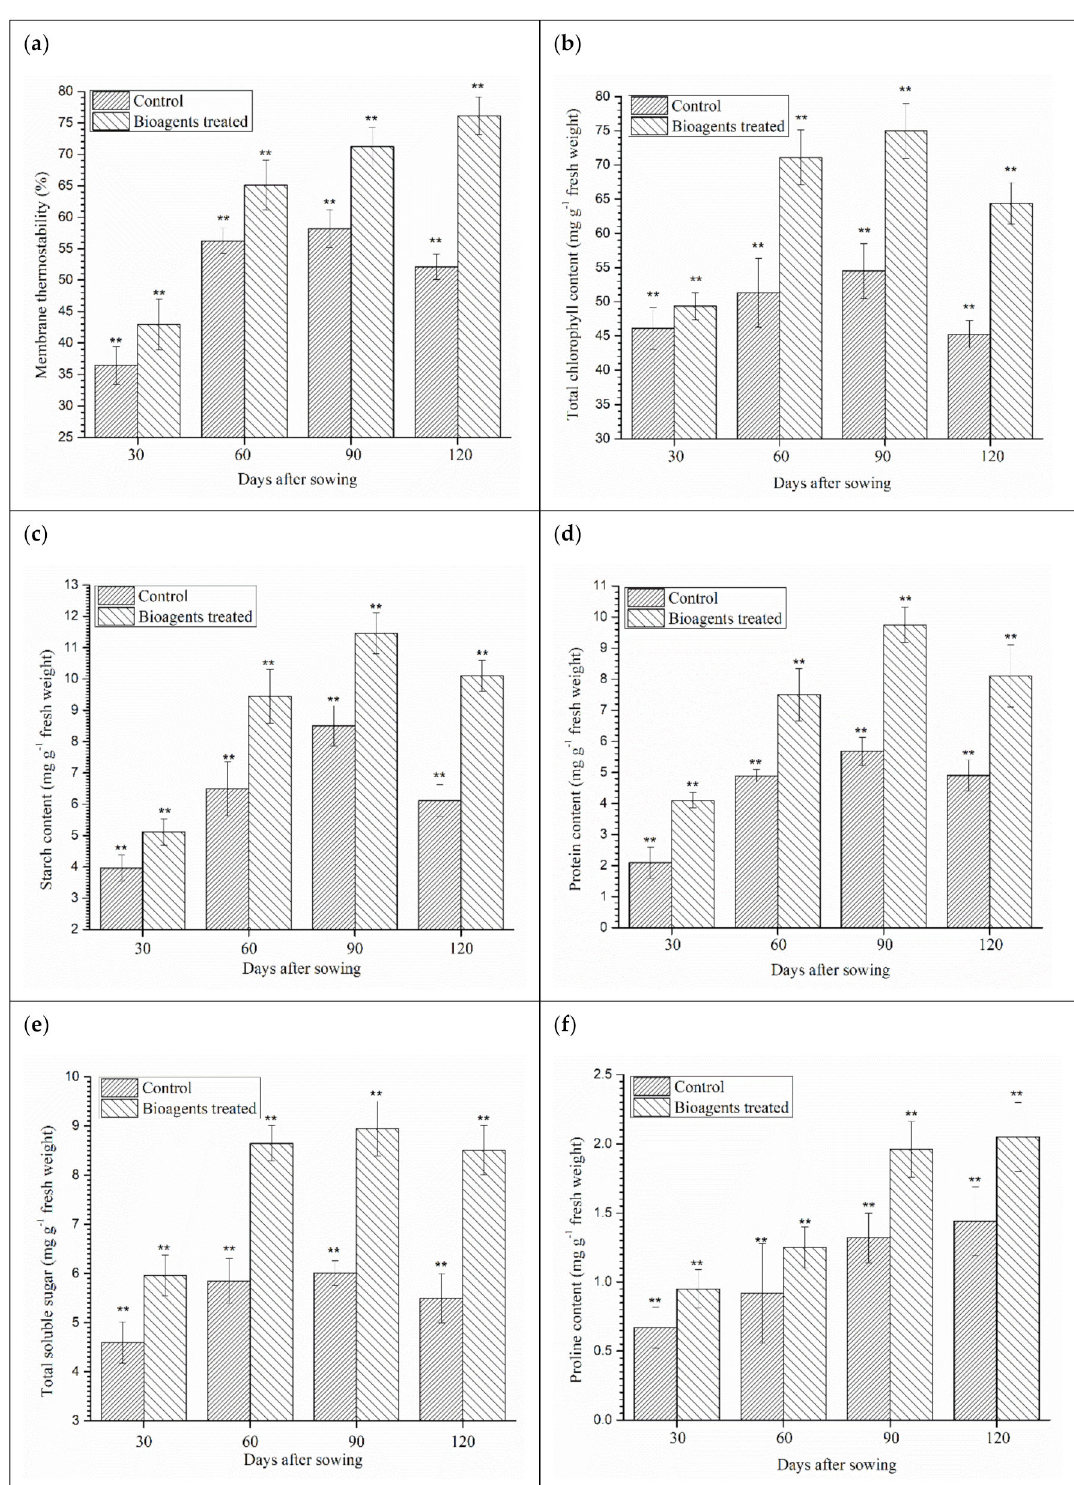
Figure 2. Effect of microbial inoculation on membrane thermostability, chlorophyll content, accumulation of biomolecules and organic solutes in wheat grown in saline sodic soil under field condition ( a ) membrane thermostability, ( b ) total chlorophyll content, ( c ) starch content, ( d ) total protein, ( e ) total soluble sugar, and ( f ) proline in wheat plants after 30, 60, 90, 120 days of sowing. Data are means and vertical bar lines represent standard deviation. Double asterisk (**) represents significant difference, while single asterisk (*) represents non-significant difference with their respective